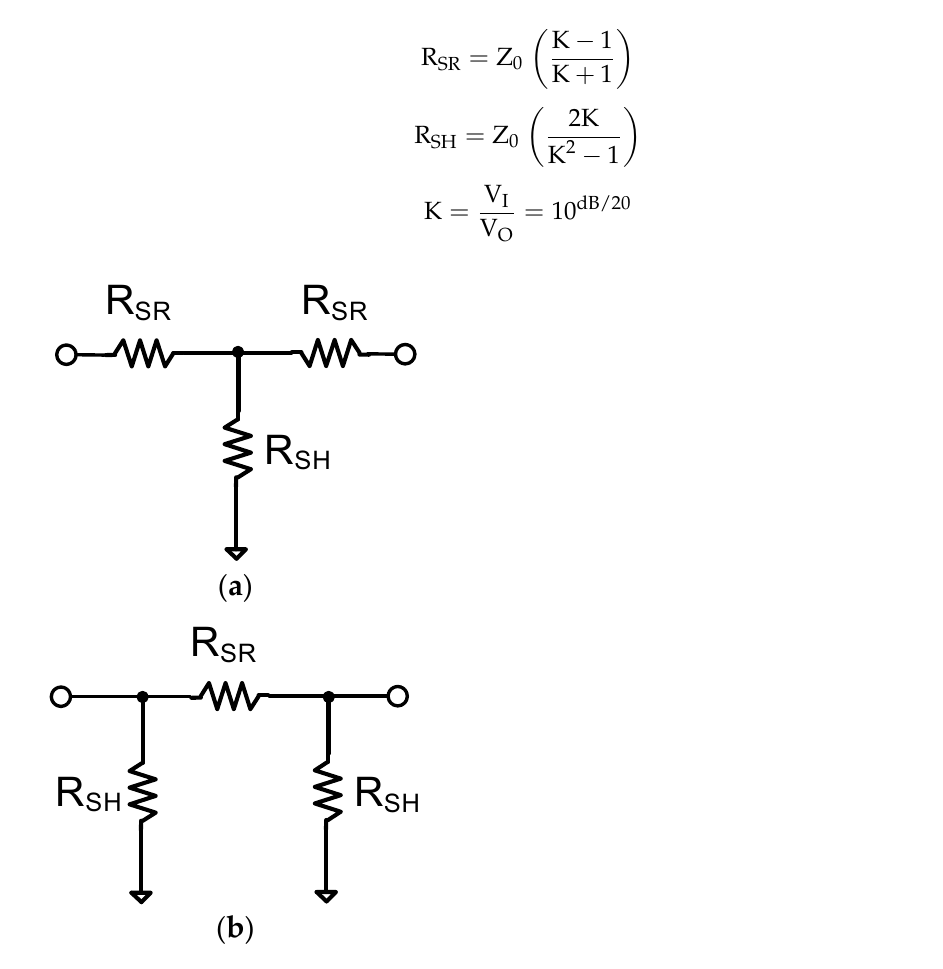
Figure 3. Schematic of ( a ) the T-type attenuator and ( b ) the π -type attenuator. Table 1. Component values of T-type resistive